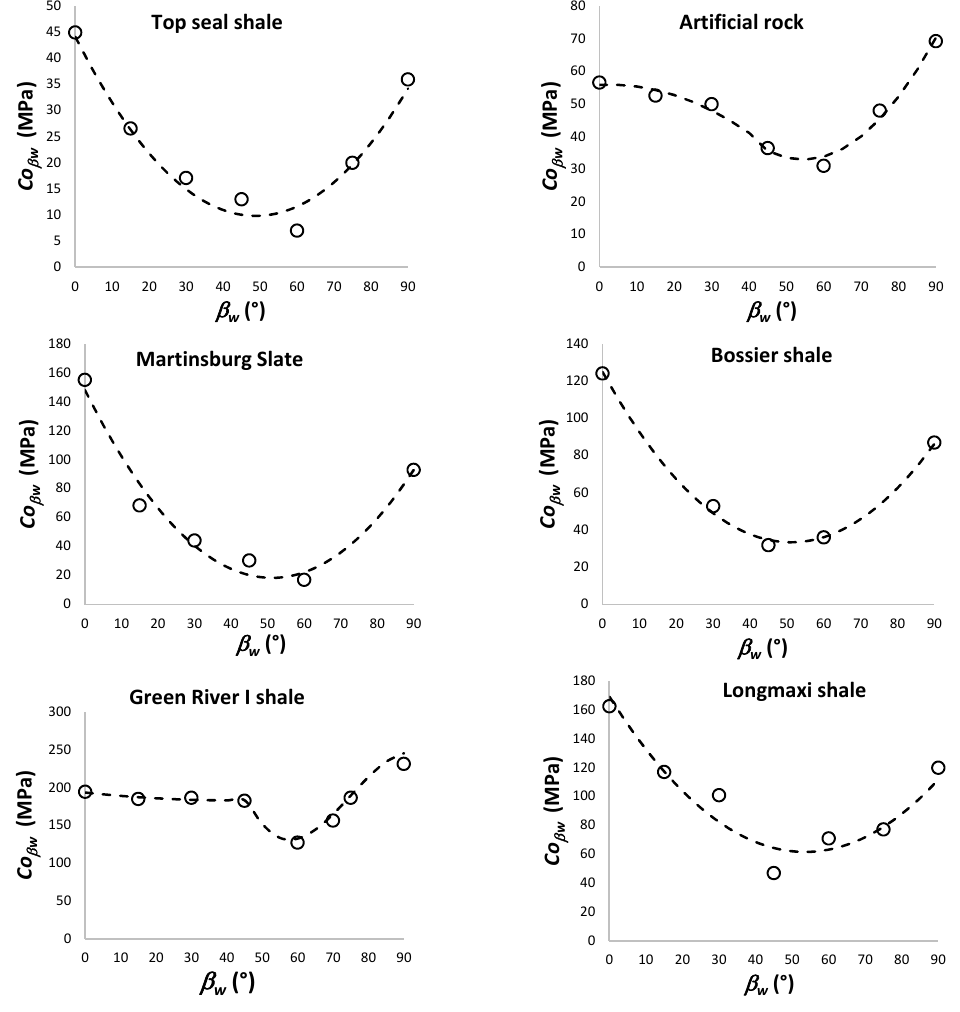
Figure 5. Values of C o β w (open circles) calculated from the linear regression of triaxial test data. The dotted lines are the polynomial functions, which interpolate the C o β w data (open circles). Table 2. Instantaneous constants m β w of the Hoek and Brown criterion.